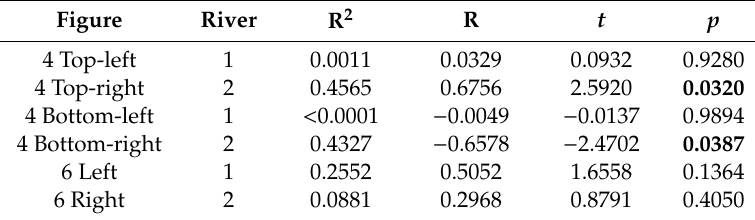
Table A3. Statistical analysis of correlation data (two-tailed t -test; null-hypothesis: no correlation; α = 0.05).